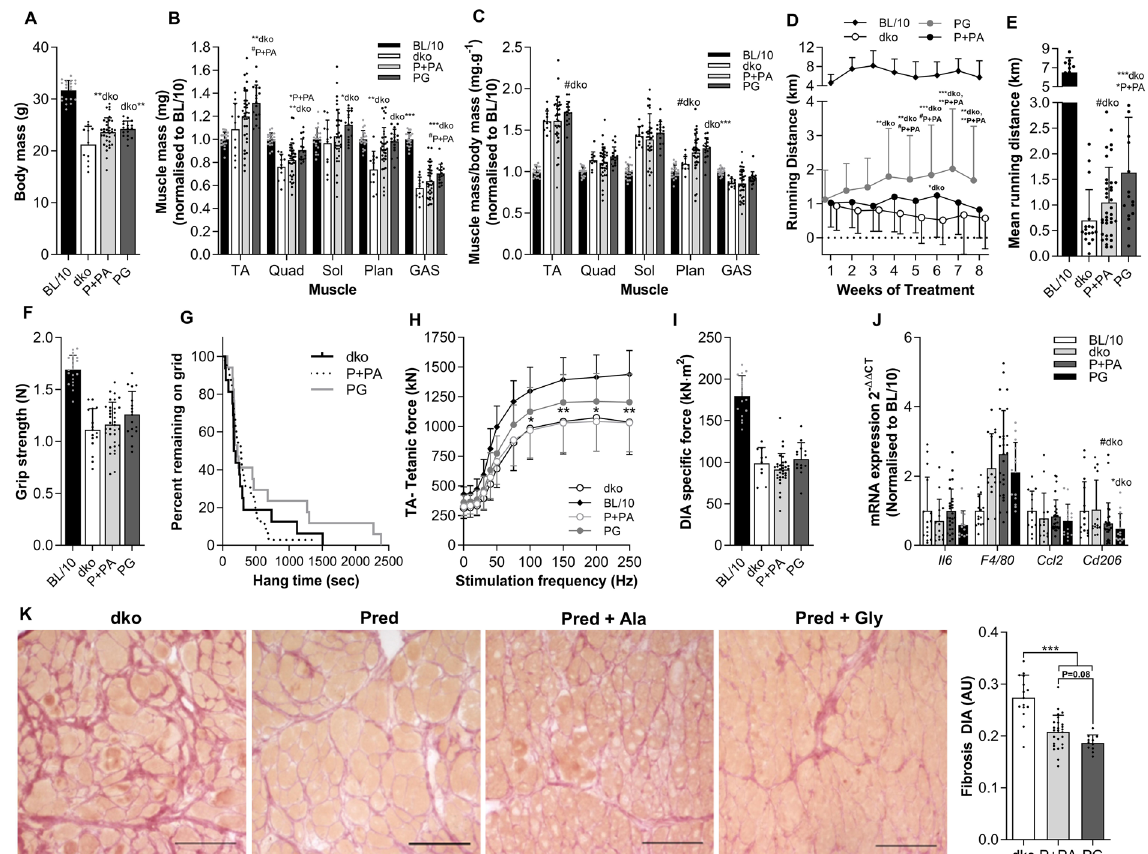
Figure 4. Glycine treatment augments prednisolone-induced improvements in voluntary wheel running and diaphragm fibrosis in dko mice. Endpoint body mass ( A ), absolute muscle mass normalized to BL/10 ( B ) muscle mass normalized to body mass and BL/10 ( C ), as well as weekly ( D ) and average ( E ) voluntary running distance in dko mice receiving prednisolone with either glycine or L-alanine for 8 weeks. Individual muscle mass in dko mice after 8 weeks of treatment ( C ). Assessments of whole body function including forelimb grip strength ( F ) and inverted hang time ( G ). The effect of glycine and prednisolone treatment on in situ peak tetanic force of the TA muscle at different stimulation frequencies ( H ), ex vivo peak specific force of diaphragm muscle in dko mice ( I ) and inflammatory gene expression ( J ). Representative muscle cross-sections stained with Van Gieson’s to visualize collagen and its quantification from dko ( K ) mice after 8 weeks of prednisolone and glycine treatment. Scale bar represents 100 µ m. Data were analyzed using one-way ANOVAs with Fishers LSD post hoc test. * denotes p < 0.05; ** denotes p < 0.01; *** denotes p < 0.001. Data are presented as mean ± SD for 12–15 mice per